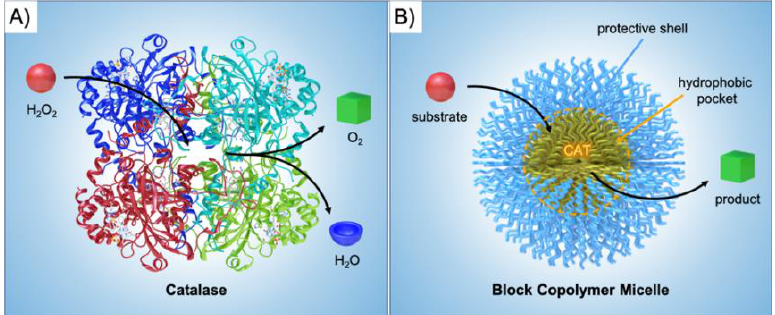
Figure 1. Catalysis in compartments. ( A ) The enzyme catalase converting H 2 O 2 to water and oxygen. ( B ) Block copolymer micelle with catalyst in the hydrophobic core compartment.